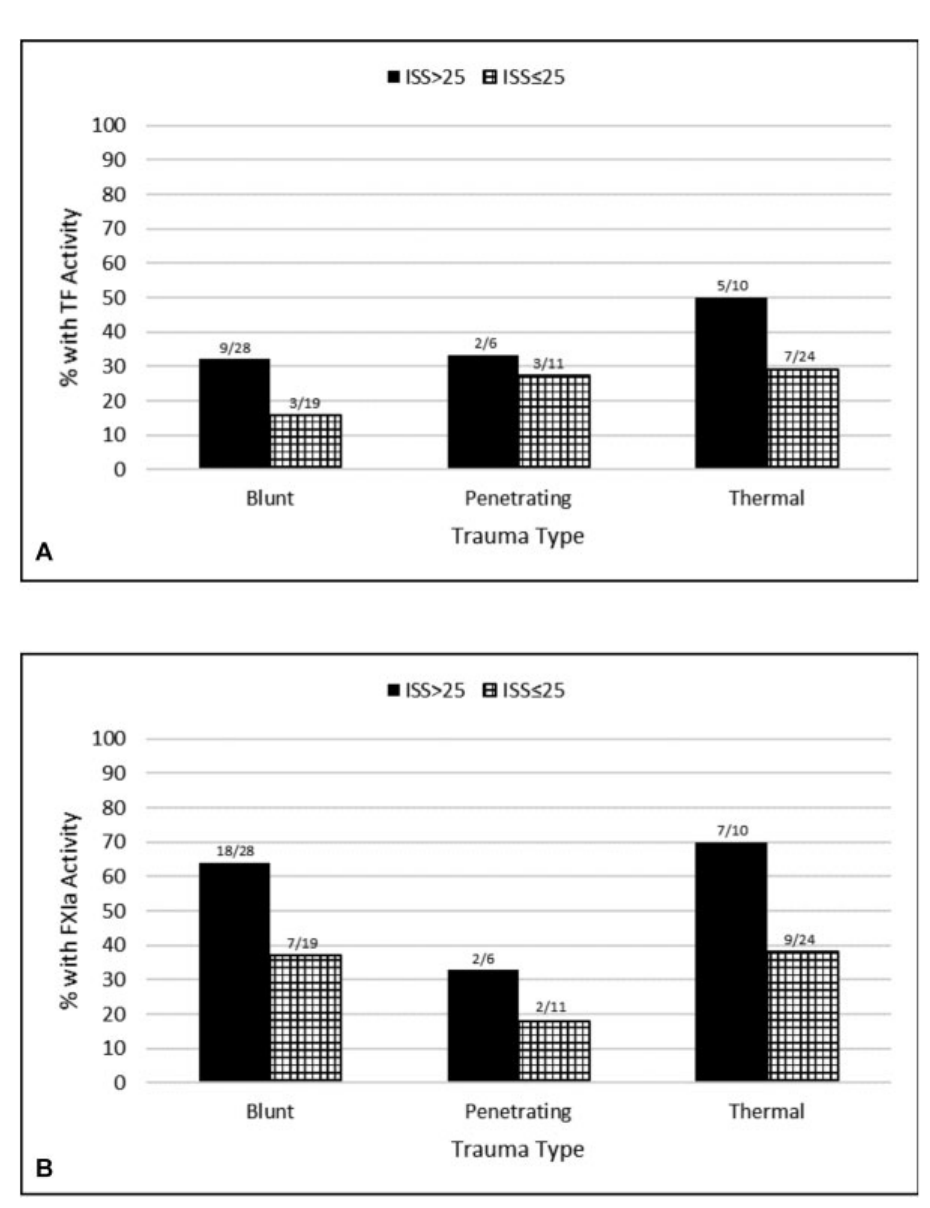
Fig. 2 TF and FXIa frequency versus ISS. Frequency of functional tissue factor (TF) (A) and active factor XIa (FXIa) (B) in plasma from trauma patients at Day 0 for subgroups with an Injury Severity Score (ISS) > 25 and ISS (cid:1) 25.